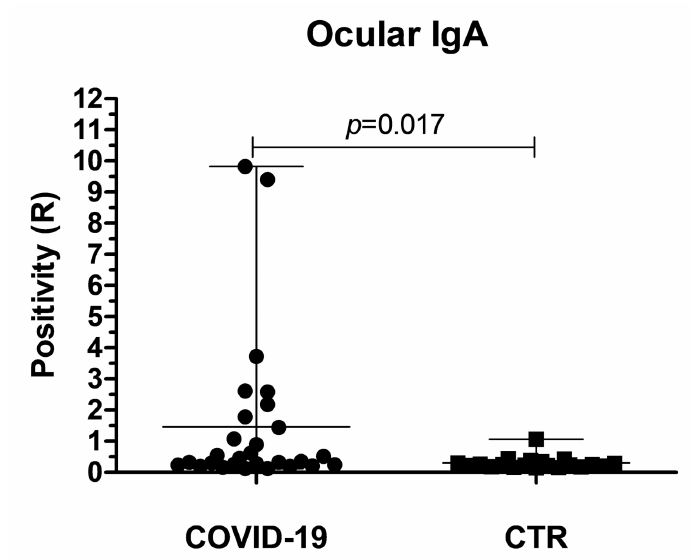
Figure 1. Presence of anti-SARS-CoV-2 specific IgA in the tears of COVID-19 patients and control subjects. Plotted values were calculated following the manufacturer’s instructions and expressed as the ratio (R) between the OD 450nm values detected in tested samples and calibrator. Each sample was assessed in triplicate. Mean and range values of both groups are also indicated, corresponding to 1.464 ± 0.46 in COVID-19 and 0.301 ± 0.04 in the control group, respectively. The p value was calculated by the Mann–Whitney non parametric test.